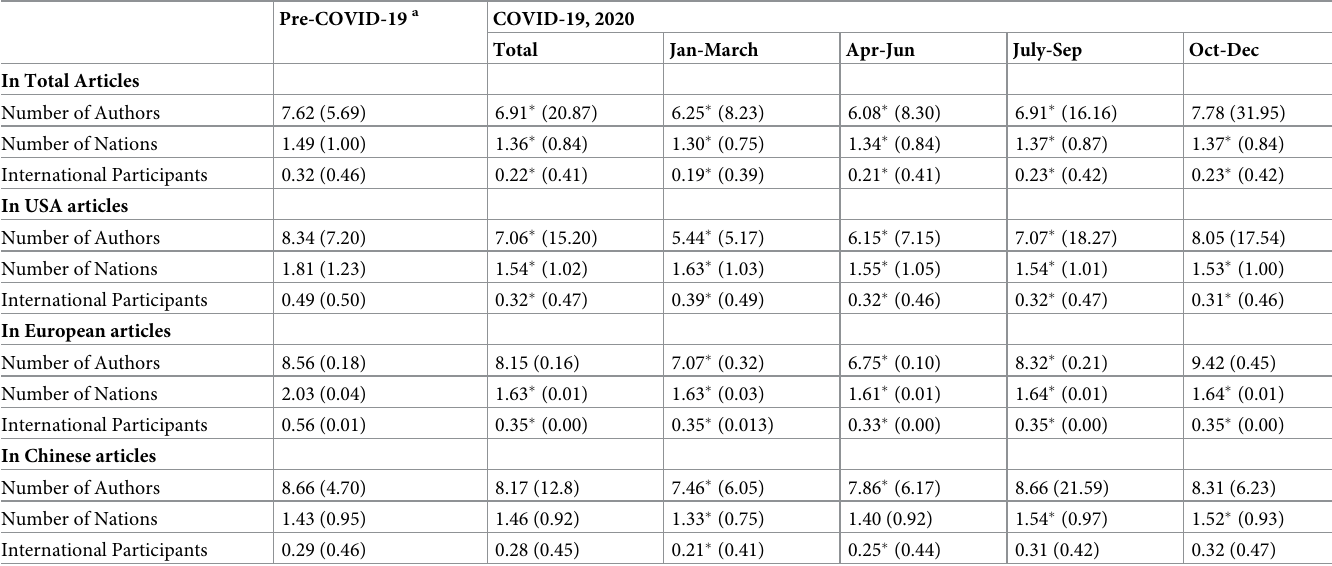
Table 5. Collaboration rate in coronavirus research.